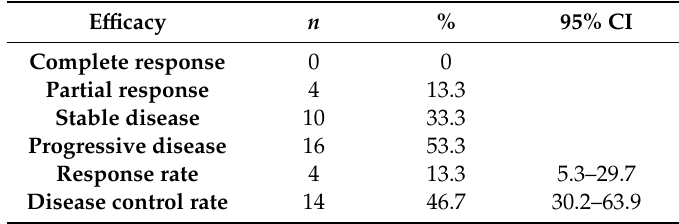
Table 4. E ffi cacy results of patients with unresectable advanced pancreatic cancer treated with second-line gemcitabine plus nab-paclitaxel after failed FOLFIRINOX.